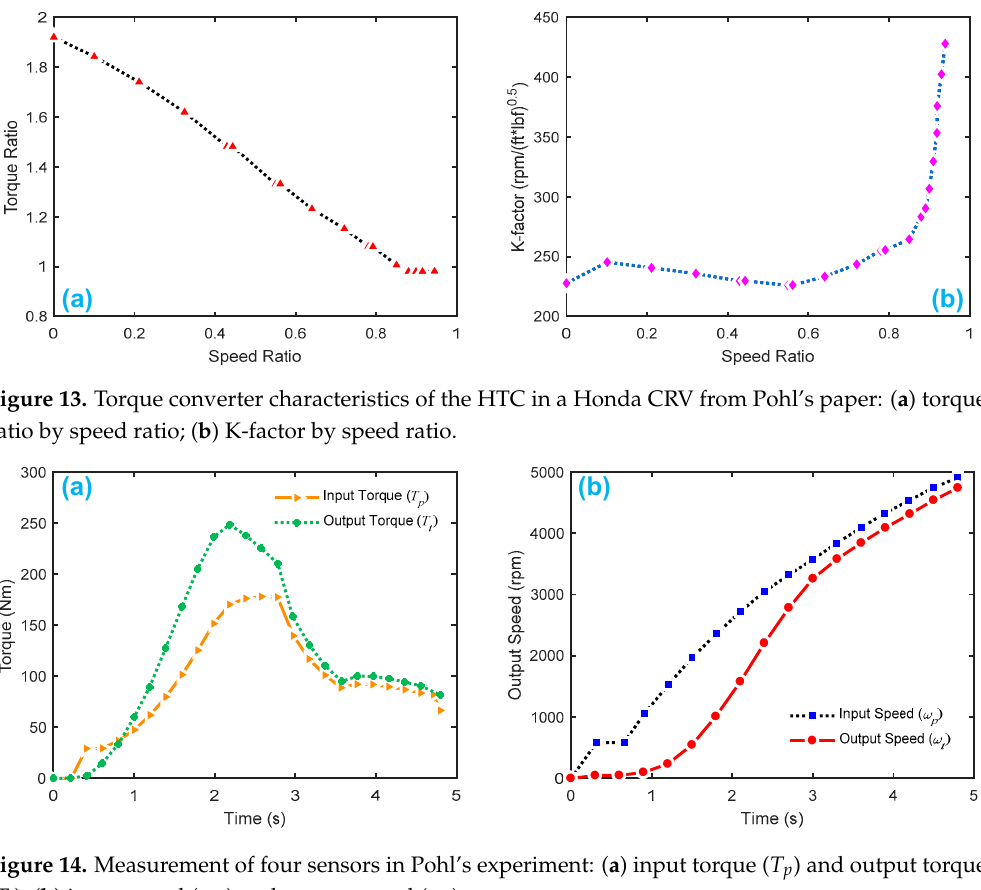
Figure 14. Measurement of four sensors in Pohl’s experiment: ( a ) input torque ( T p ) and output torque ( T t ); ( b ) input speed ( ω p ) and output speed ( ω t ).